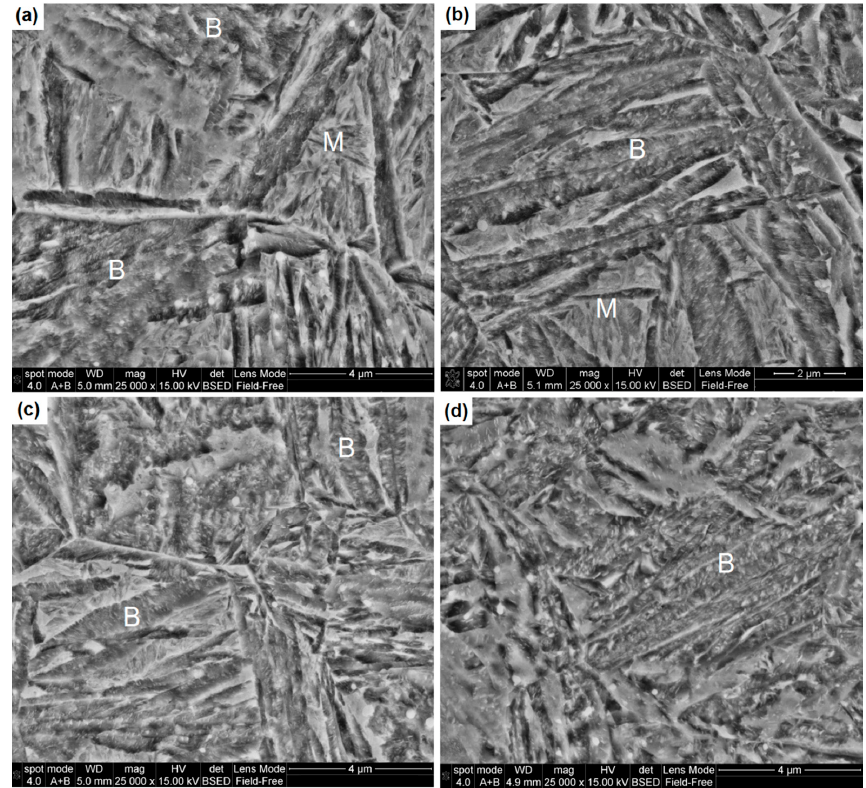
Figure 5. High-magnification FEG-SEM images of samples austempered for different durations: ( a ) 10 min; ( b ) 20 min; ( c ) 40 min; and ( d ) 80 min. Note the growth of bainitic ferrite.